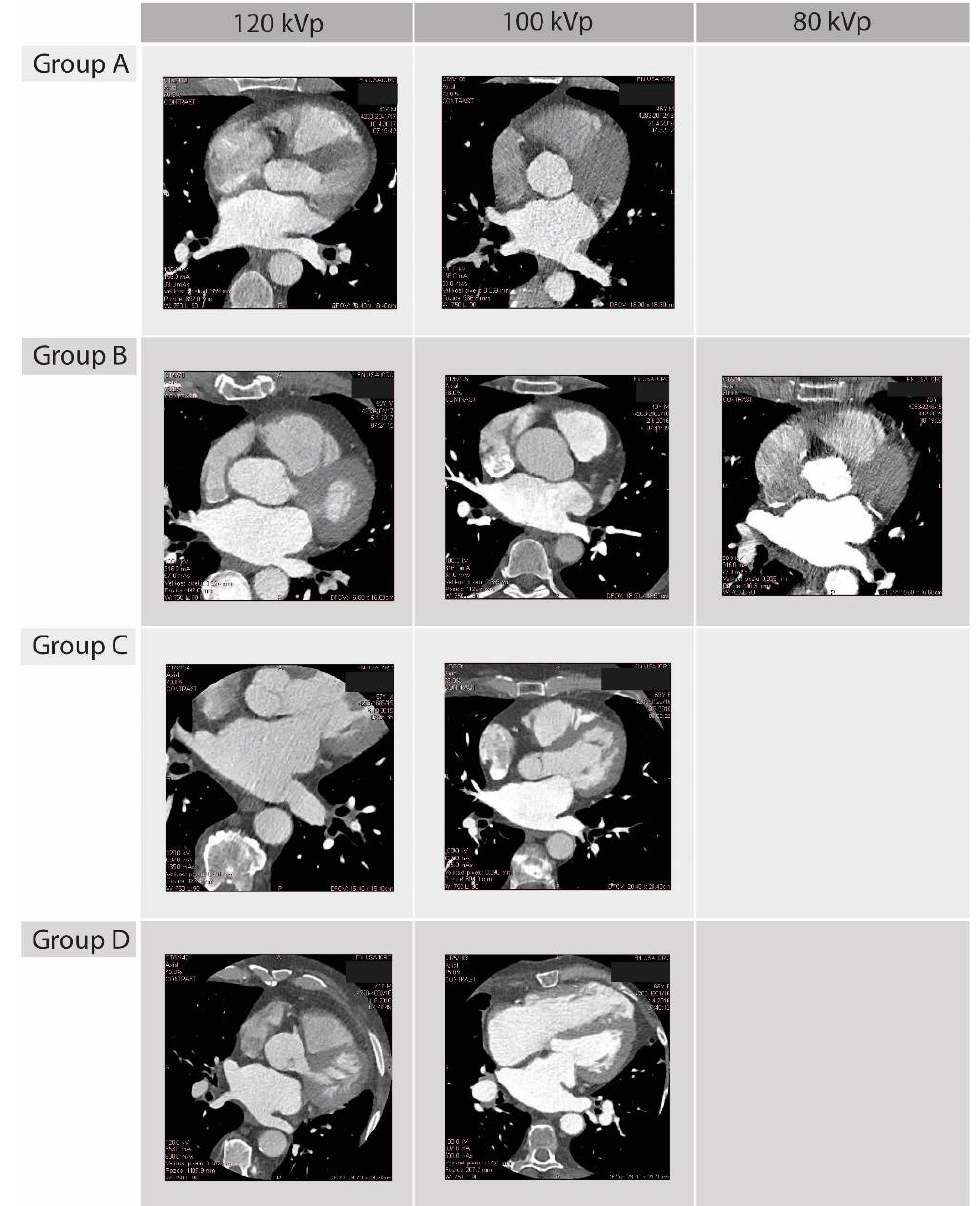
Figure 1. Examples of LA images performed using Group A–D scanning protocols. A 256-row multidetector CT with body weight-dependent tube voltage of 80 kVp (<70 kg), 100 kVp (70–90 kg), and 120 kVp (>90 kg) was used with tube current of 33 mAs, 67 mAs, 135 mAs and 600 mAs for Group A–D, respectively.